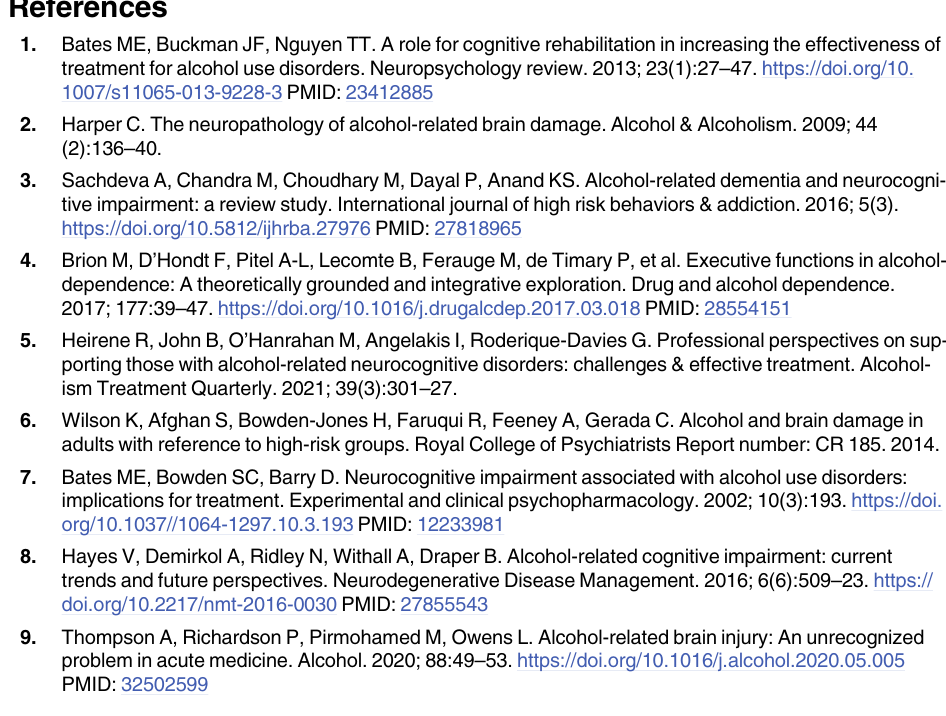
S2 Table. Critical appraisal of studies about the accuracy, validity and/or reliability of a cognitive assessment